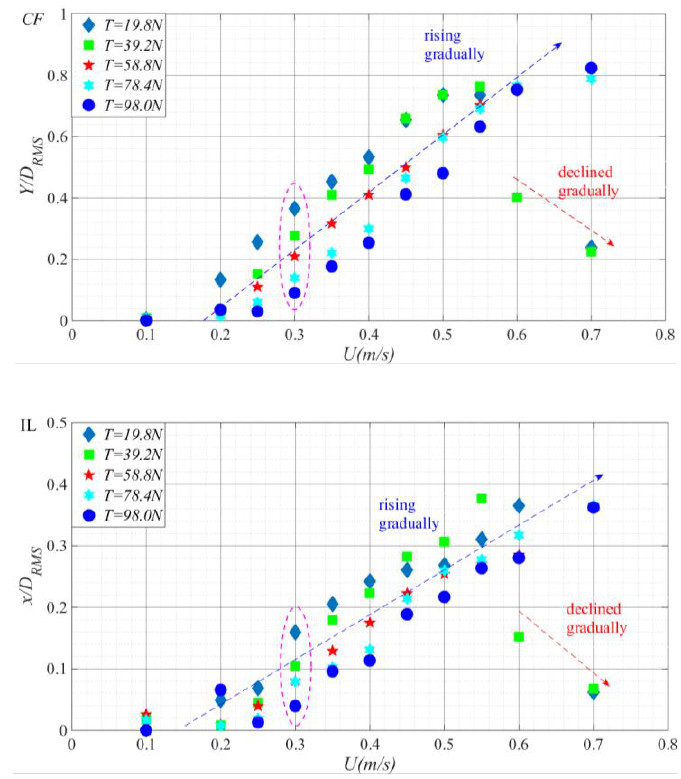
Figure 9. Cross-flow and in-line riser RMS dimensionless displacements versus flow velocity under different top tensions.